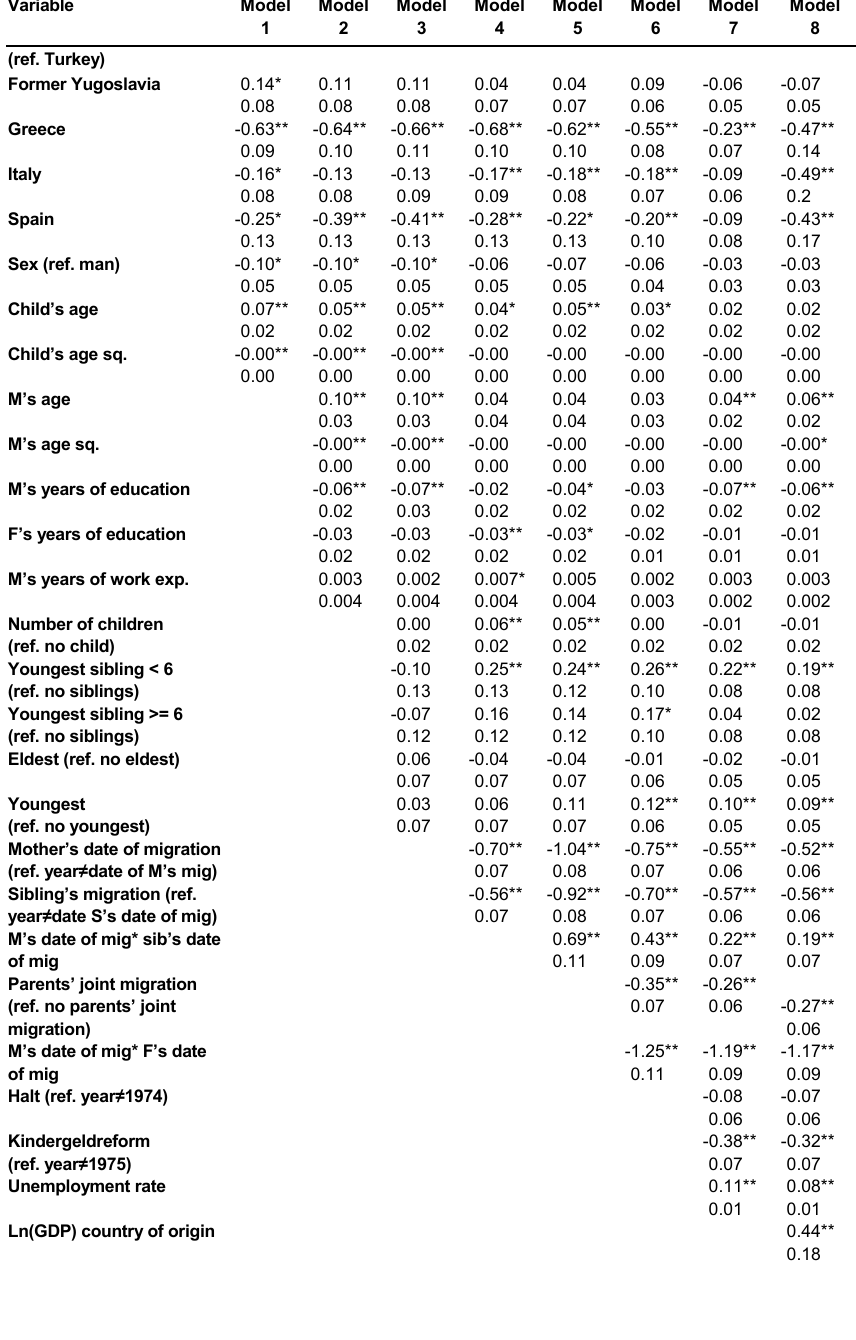
Table 5. Weibull accelerated failure time model estimates of children’s